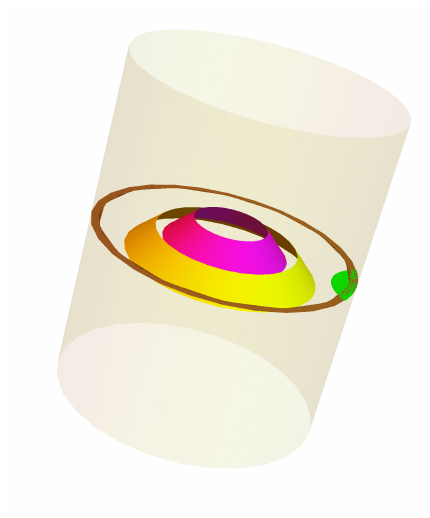
Figure 1: Support of the operators A totic region (brown) supporting P Ω and green region supporting Q